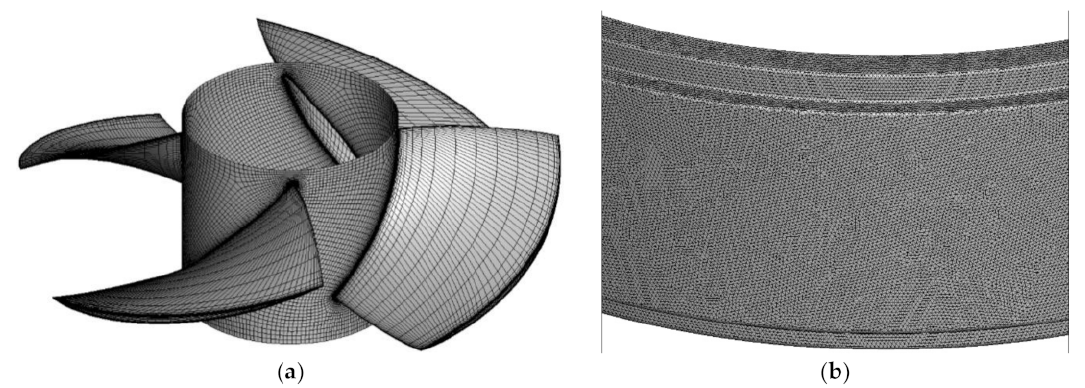
Figure 2. The generated gird of the impeller and rotor: ( a ) the grid of blade, ( b ) the grid of